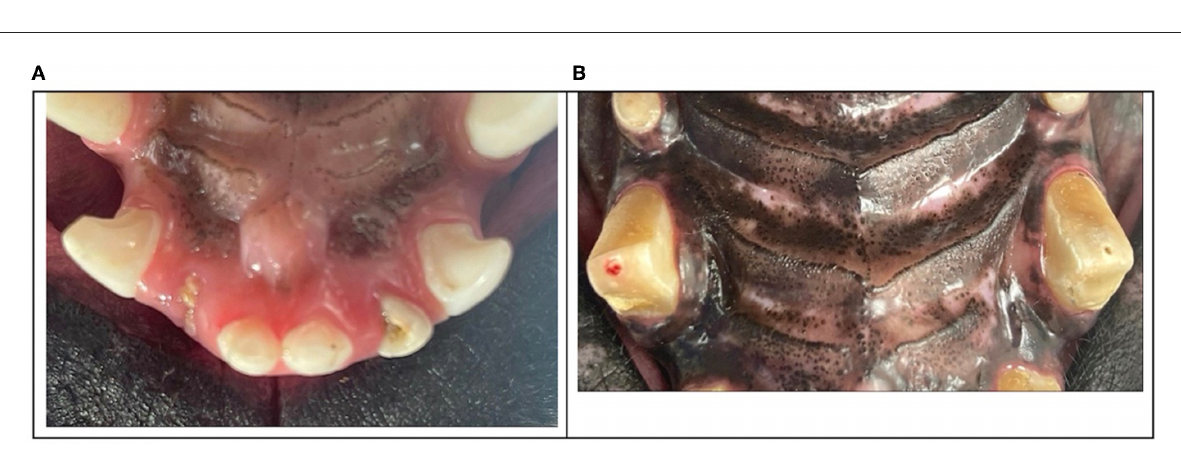
average teeth fractured when compared to MWDs